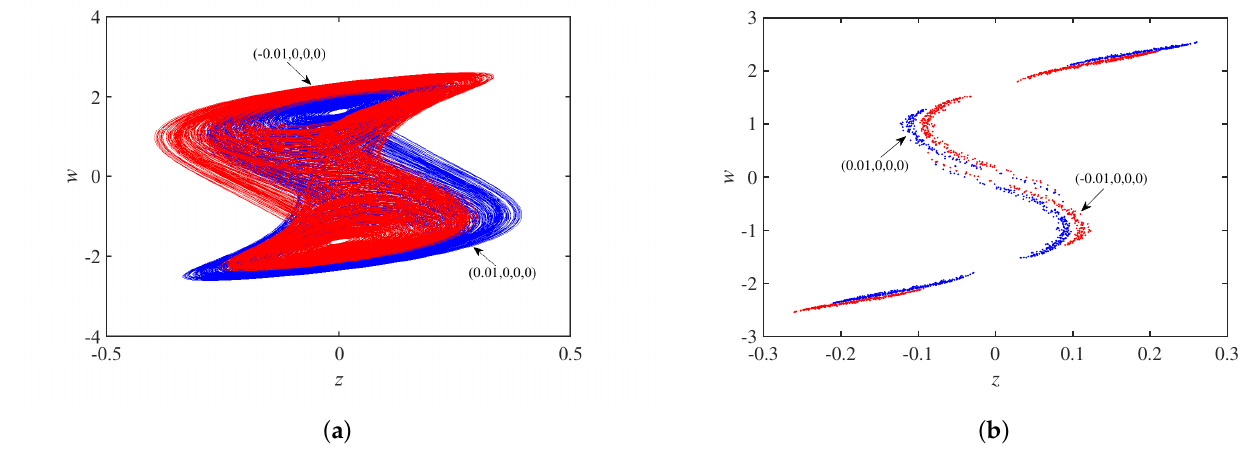
Figure 14. When a = 33, b = 0.15, c = − 0.2: ( a ) coexisting double-scroll attractors; ( b ) Poincaré maps.